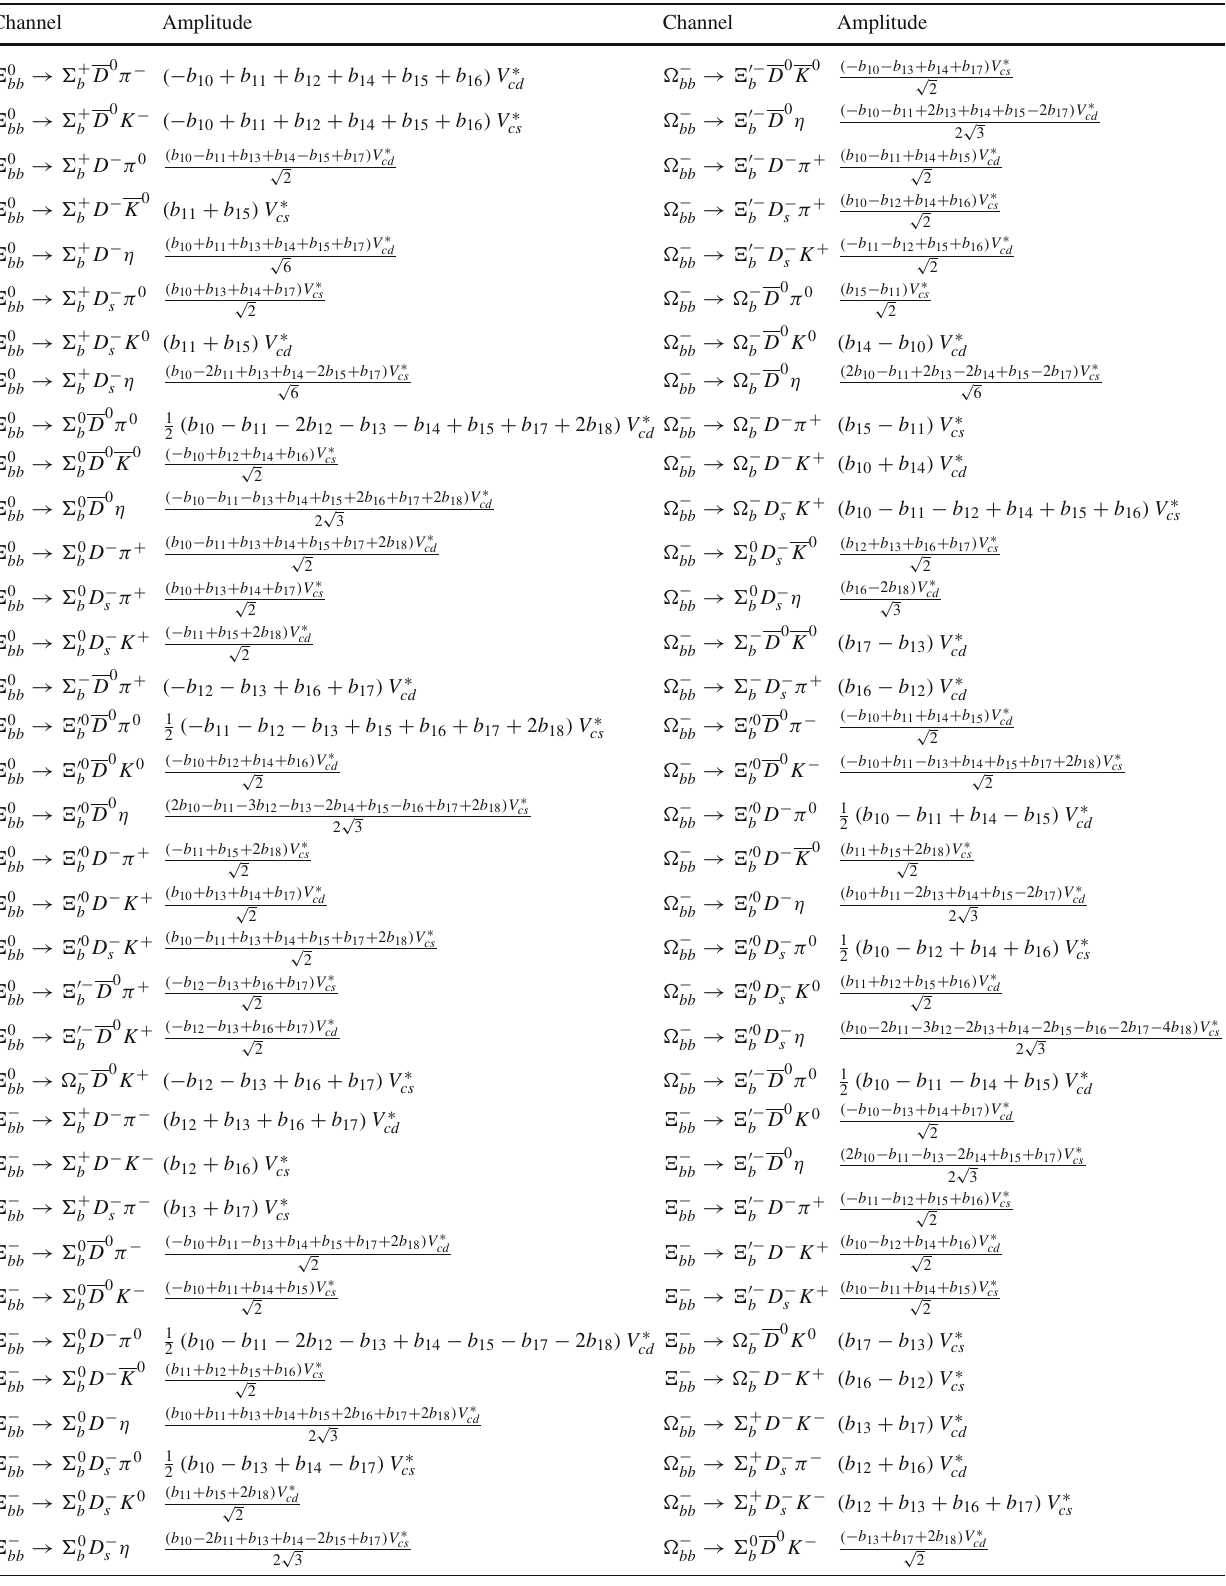
Table 21 Doubly bottom baryon decays into a bqq (sextet), an anti-charmed meson and a light meson Channel Amplitude Channel